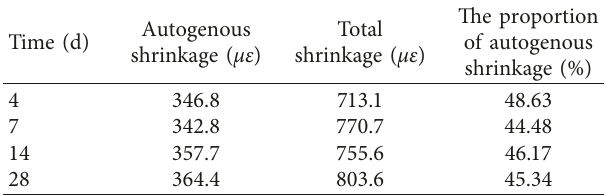
Table 4: Comparison between the calculated value of autogenous shrinkage and total shrinkage in dry